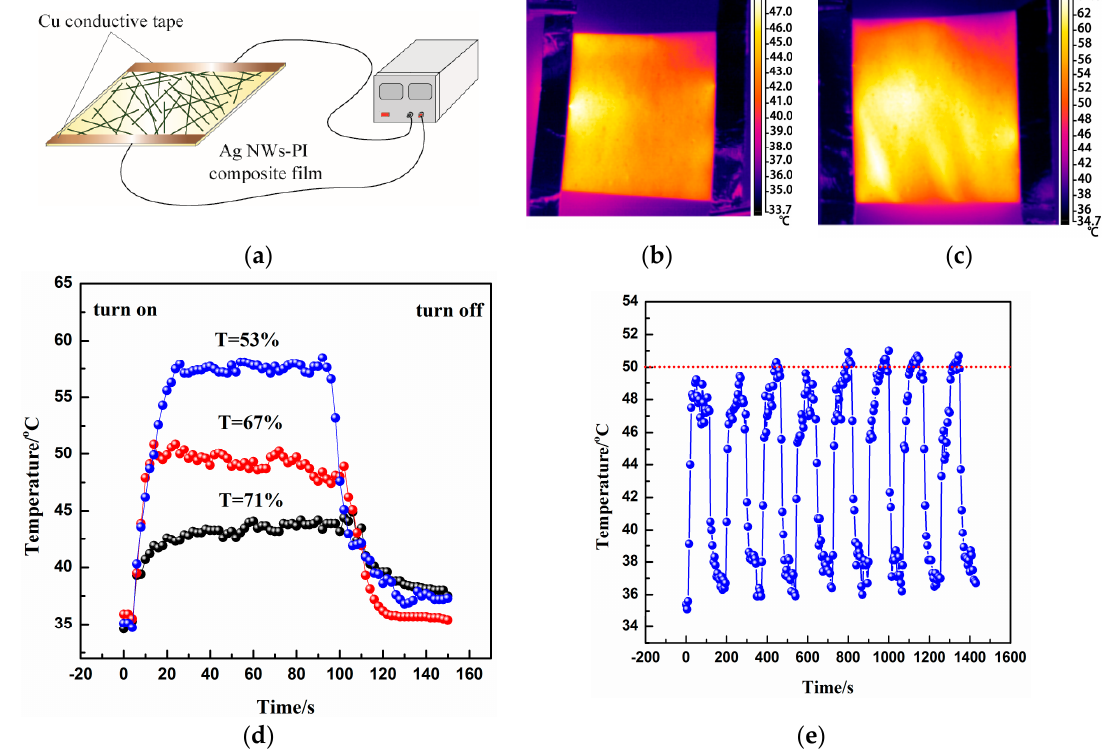
Figure 4. ( a ) Schematic illustration of a film heater based on the Ag NW-PI film; Infrared thermal images of the composite films with the transmittance of 71% ( b ) and 53% ( c ) at 3.5 V; ( d ) Evolution of the temperature of Ag NWs-PI composite films with the transmittance of 71%, 67% and 53% at 3.5 V; ( e ) cycling performance of the film heater with transmittance of 67% at 3.5 V.